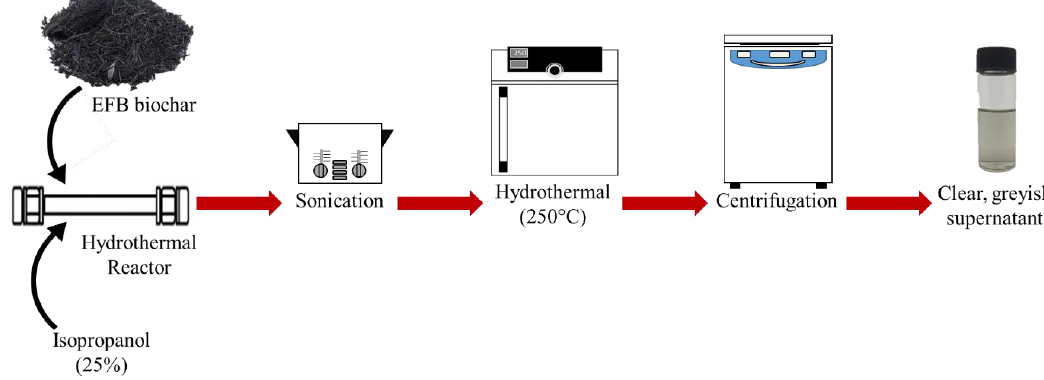
Figure 1. Schematic illustration of acid-free hydrothermal process from empty fruit bunch (EFB) biochar.